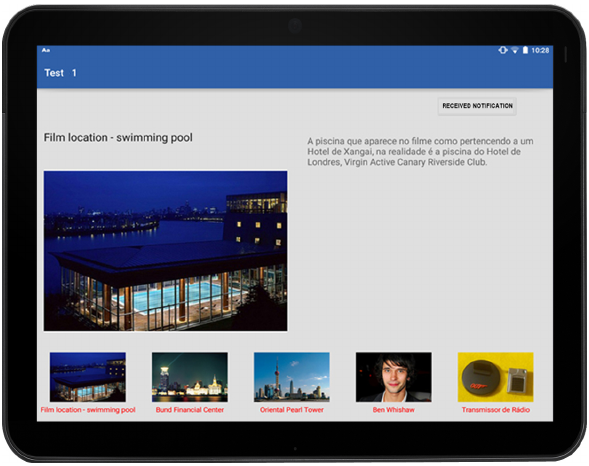
Figure 1 – The Application